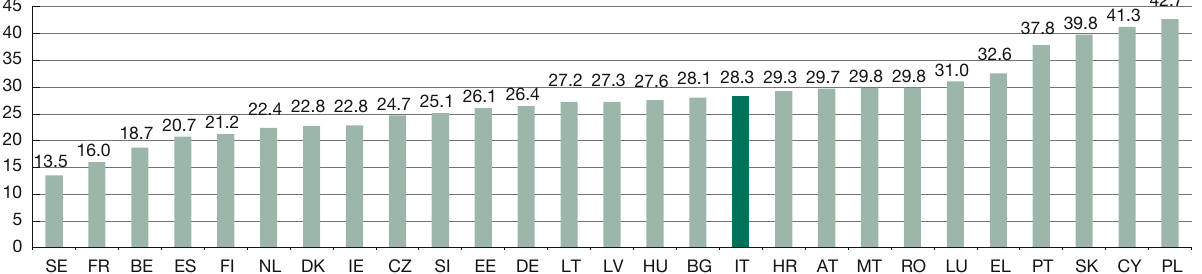
Figure 4 Absolute poverty rate in Italy, 2005-2018